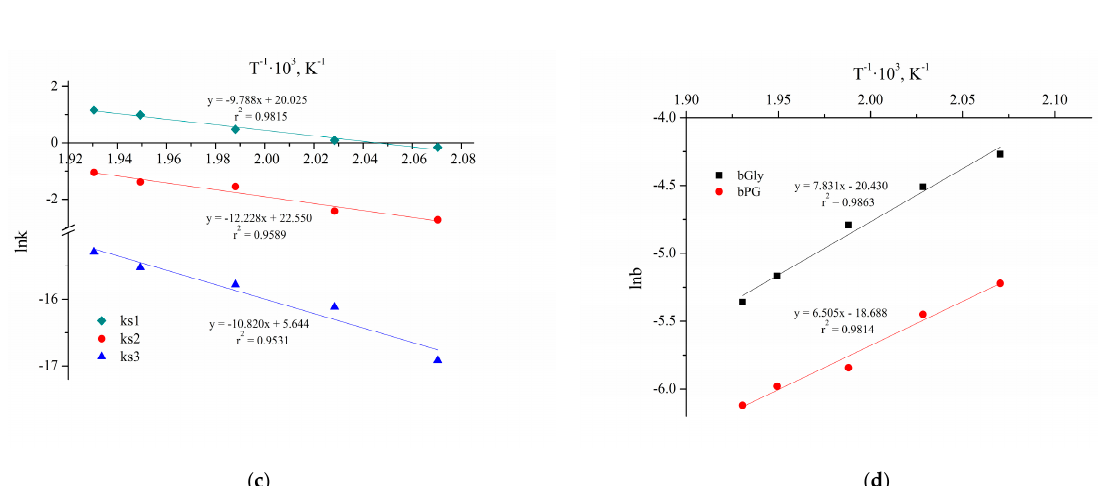
Table 7. The calculated values for the activation energies and pre-exponential factors.